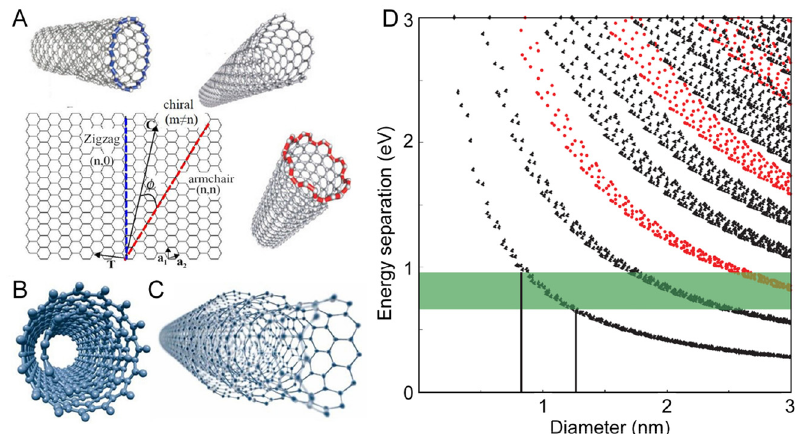
Figure 1: Fundamentals of CNTs: (A) Structures SWCNT in function of chirality (zigzag, armchair, and chiral); (B) Structure of DWCNT; (C) Structure of MWCNT made up of several concentric shells, Tîlmaciu et al. plot, each point represents a different diameter and chirality of the graphitic arrangement of SWCNTs, the black and red dots represent semiconducting and metallic nanotubes, respectively. The green region shows semiconducting nanotubes with diameters between 0.8 and 1.3 nm can be used for saturable absorption